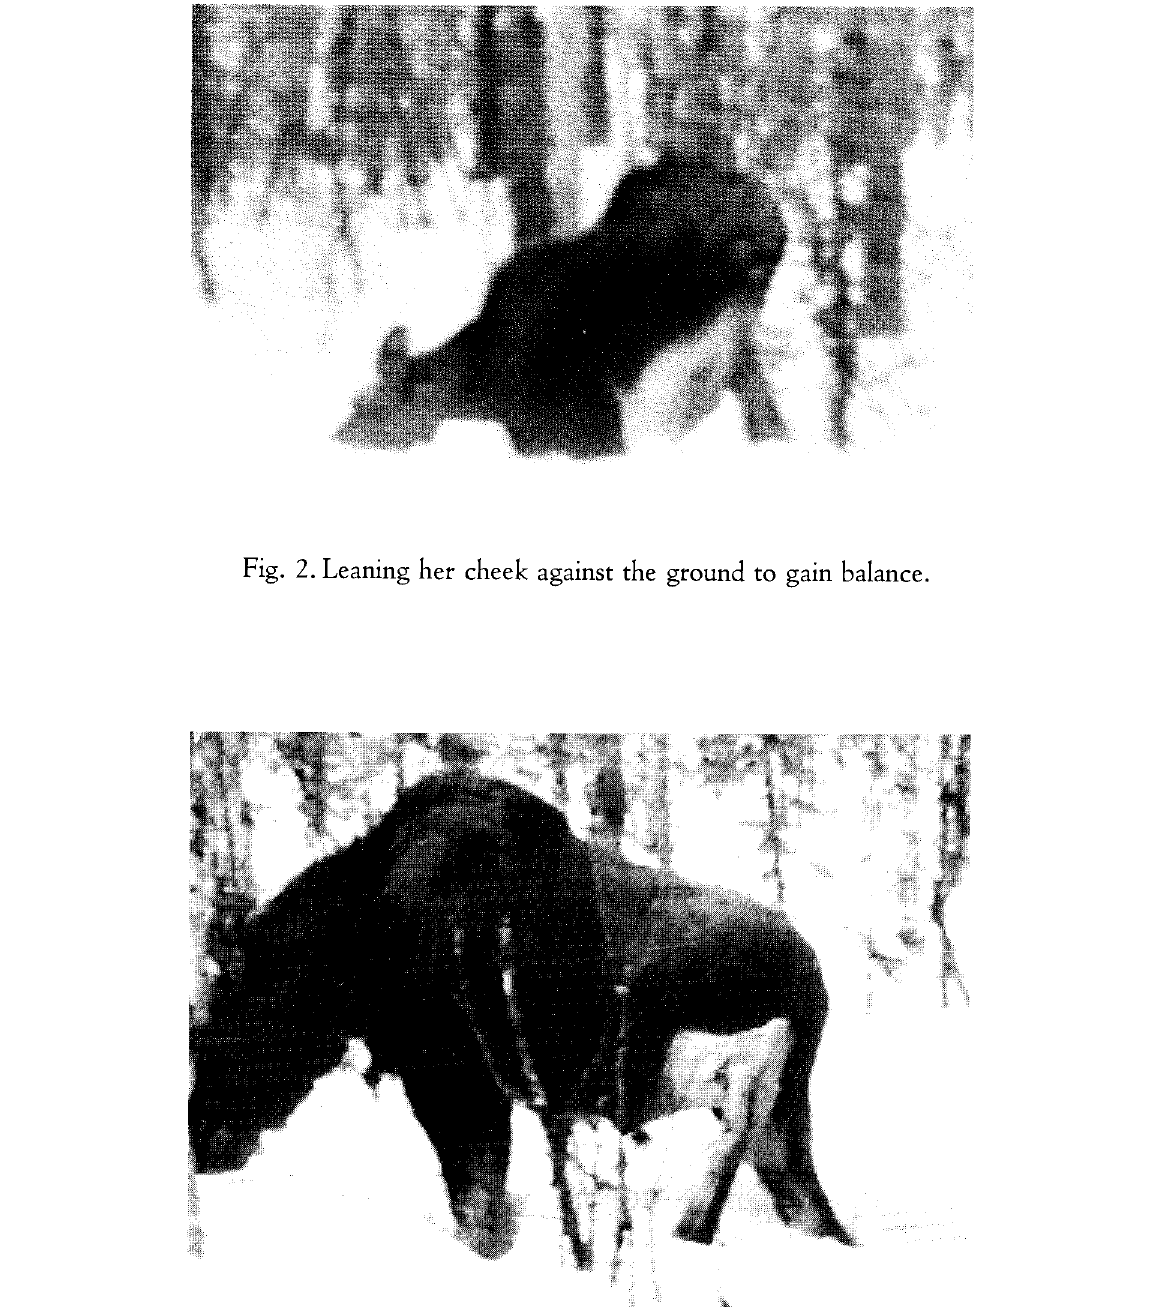
Fig. 2. Leaning her cheek against the ground to gain